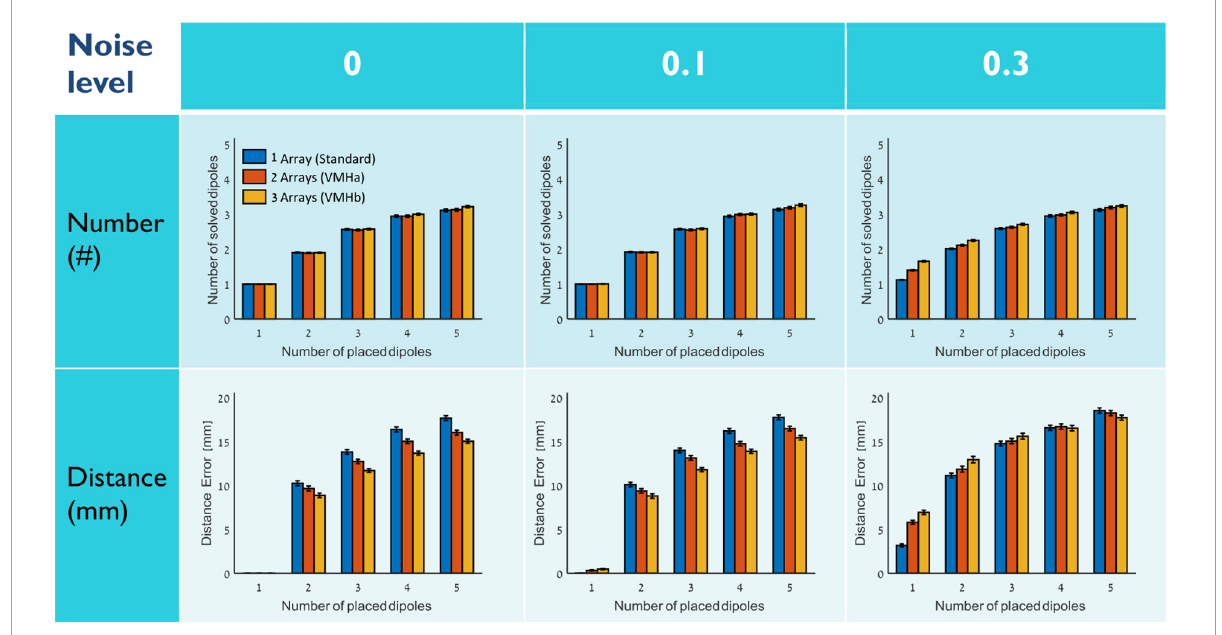
FIGURE2 Source localization accuracy by VMHs. The number (top row) and the distance accuracy (bottom row) of solved dipoles vs. placed dipoles (between one and five dipoles) at noise levels of 0, 0.1, and 0.3. The number of combined MEG arrays in VMH is marked by color: 1 (standard)-blue, 2 (VMHa)-red, and 3 (VMHb)-yellow. Each bar represents a mean ± SEM across 1,000